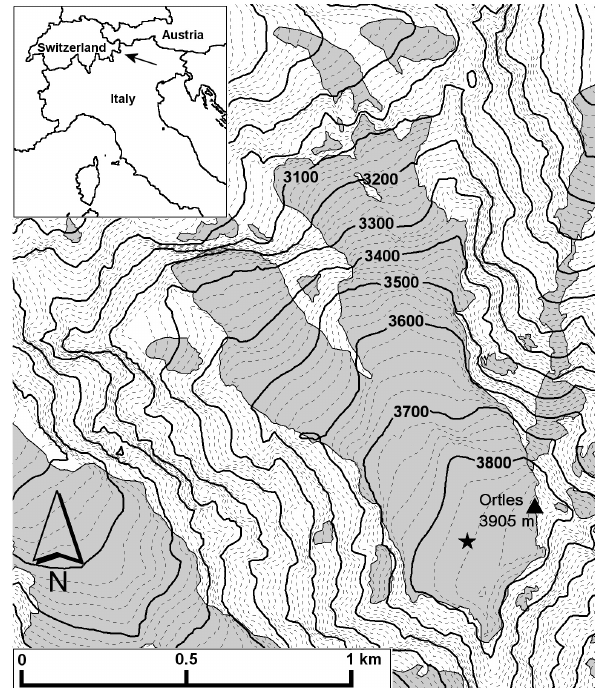
Fig. 1. Map of the Alto dell’Ortles glacier, Southern Rhaetic Eu- ropean Alps, (Autonomous Province of Bolzano – South Tyrol). In grey the glaciarized areas are reported. The star indicates the sam- pling site while the glaciarized areas are reported in grey (adapted from Gabrielli et al.,